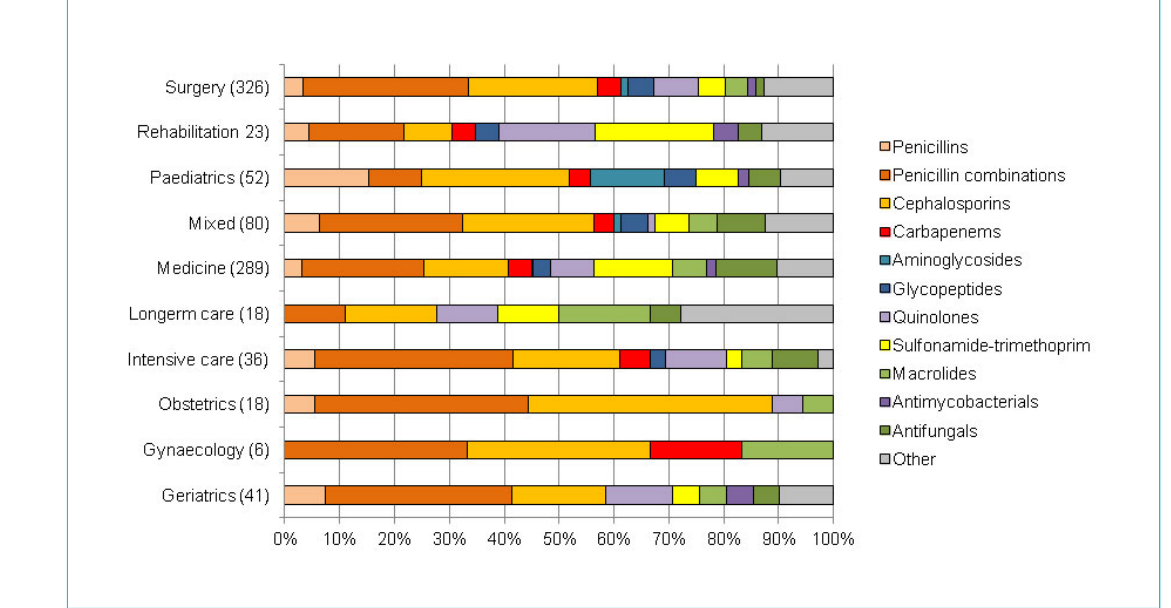
Figure 4: Antimicrobial classes by ward specialty – multicentre point prevalence survey, Switzerland